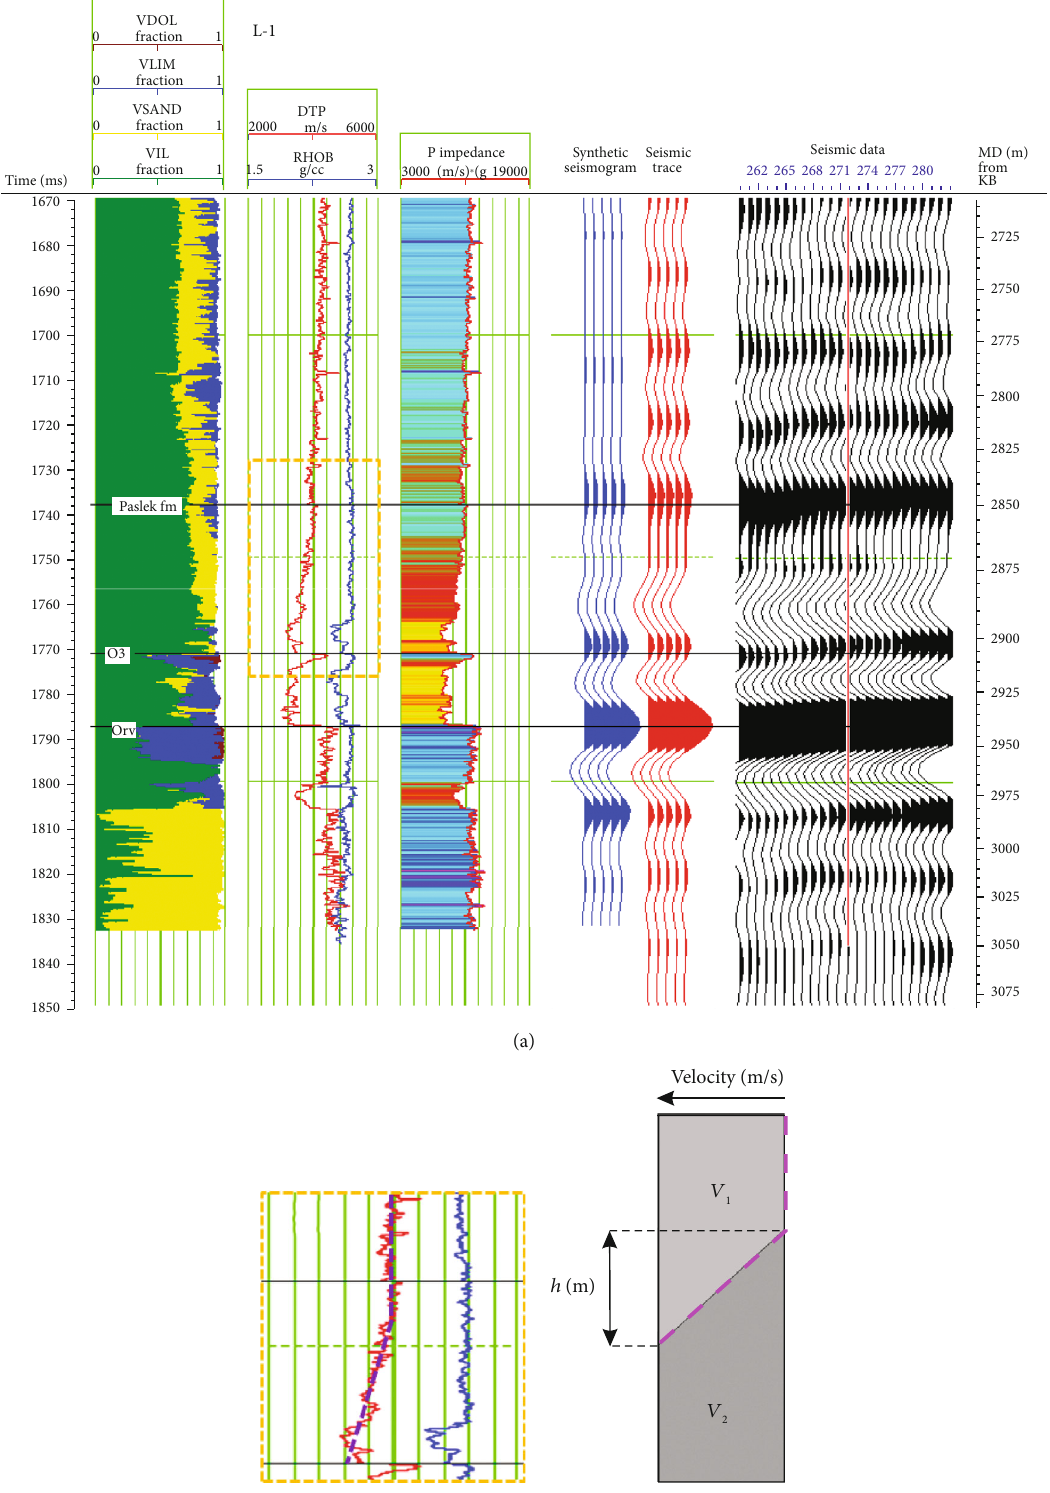
Figure 7: (a) From left: lithology, Vp (red curve), density (blue curve), P wave impedance, synthetic seismogram (blue), seismic traces (red), and seismic with location of well (red line); (b) enlarged part with a linear approximation of velocity (red dashed line) and density (blue dashed line); (c) seismogeological model of a transition